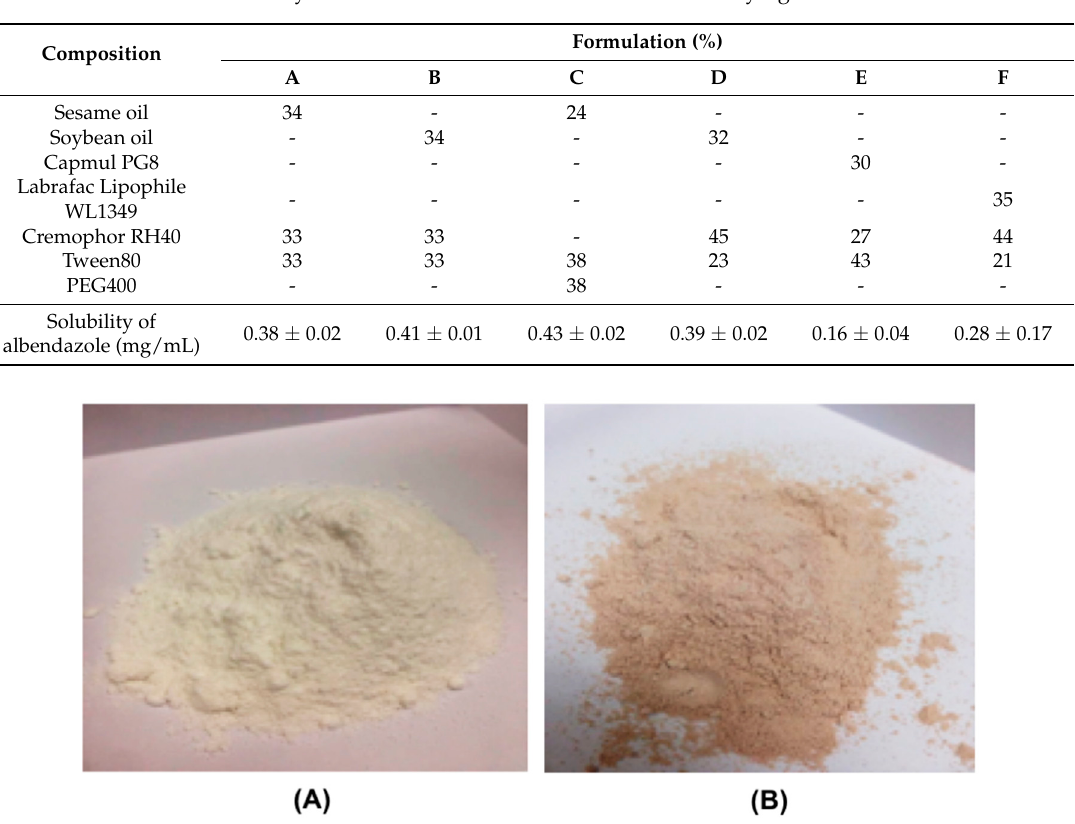
Figure 5. Appearance of albendazole self ‐ microemulsifying chewable tablets: ( A ) microemulsion absorbed from colloidal silica and ( B ) albendazole self ‐ microemulsifying granules.